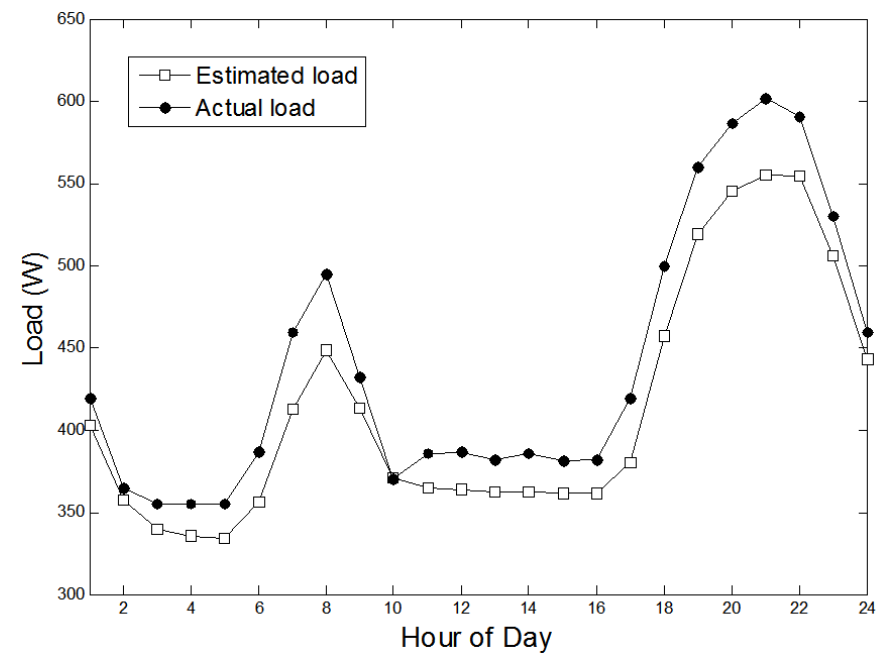
Figure 13. Actual and estimated load demands for Scenario 1.